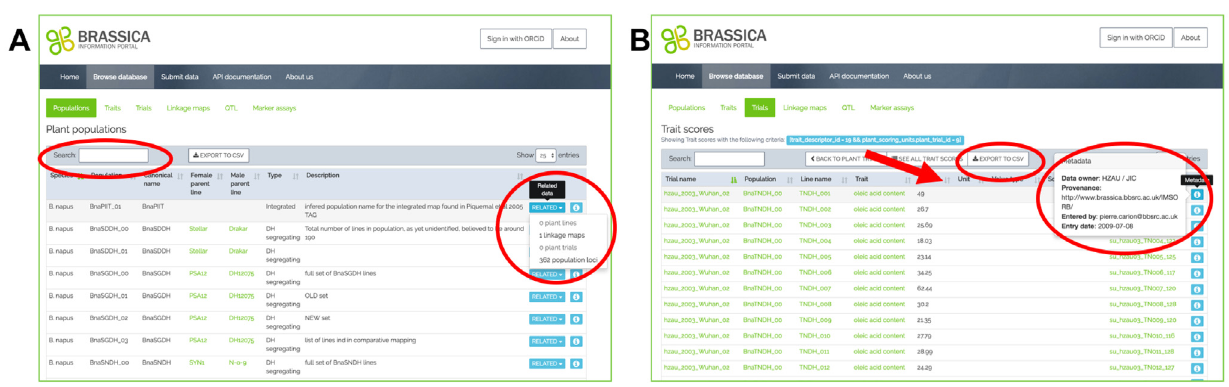
Figure 4. Multiple mechanisms to find, navigate and access data in BIP. A ) refined querying and access to related data B ) reordering of results, function for bulk download of data with accompanying metadata, display of the meta-data.